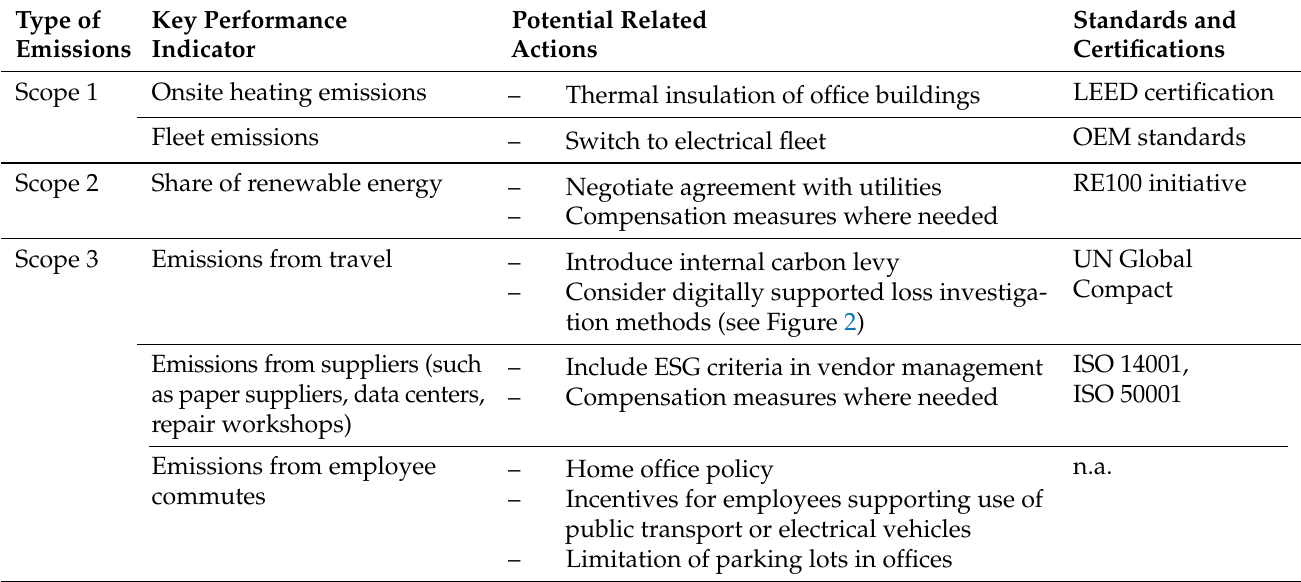
Table 4. Illustrative examples on key performance indicators, related actions and frequently referred- to standards and